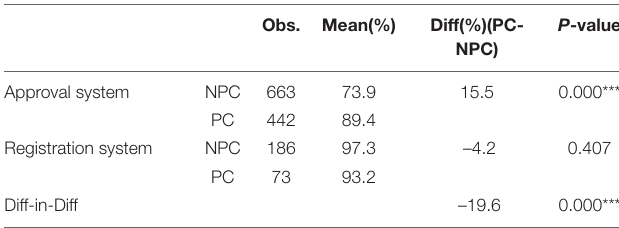
TABLE 2 | Univariate test.